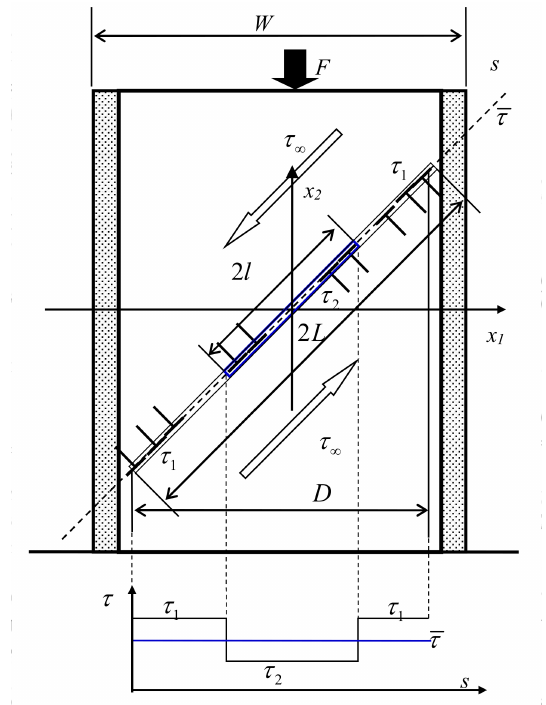
Figure A2. Flow model incorporating the effects of amorphous surface layer and varying internal friction (critical shear